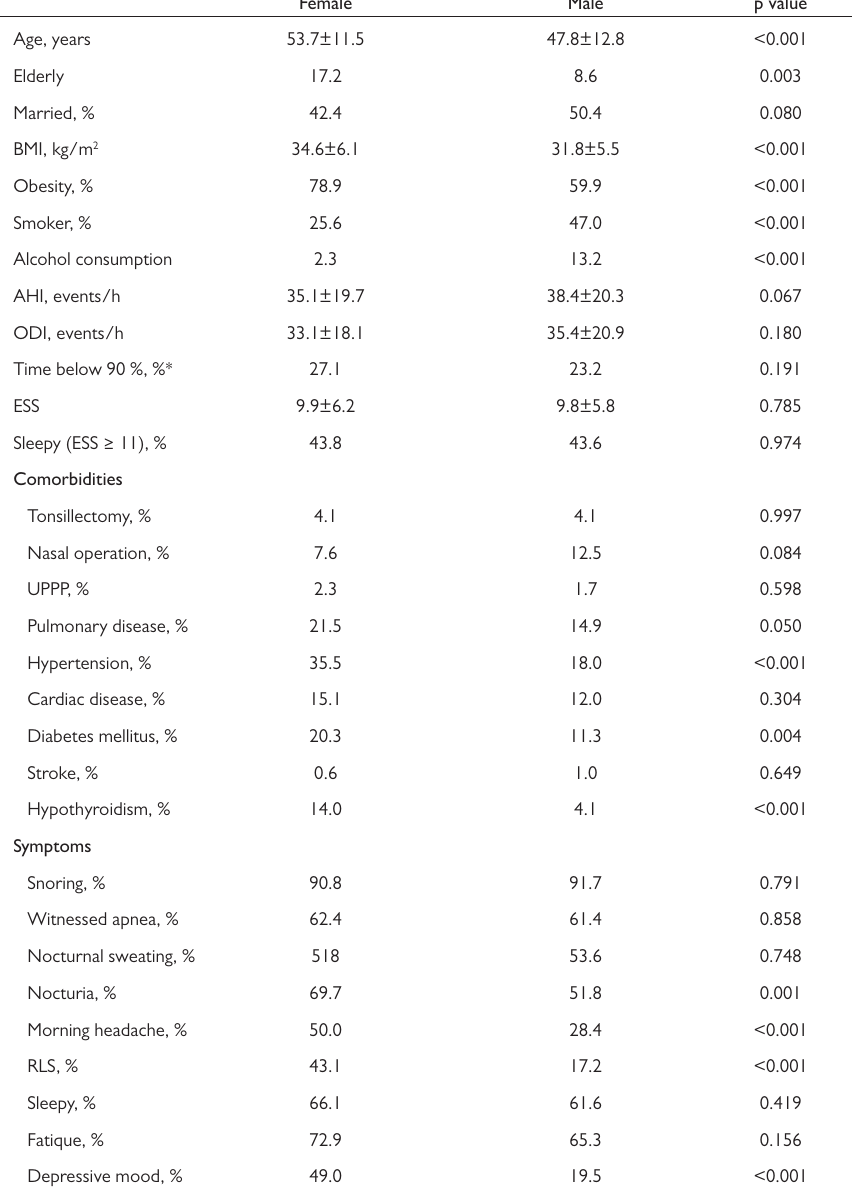
Table 2. Clinical characteristics of Obstructive sleep apnea patients